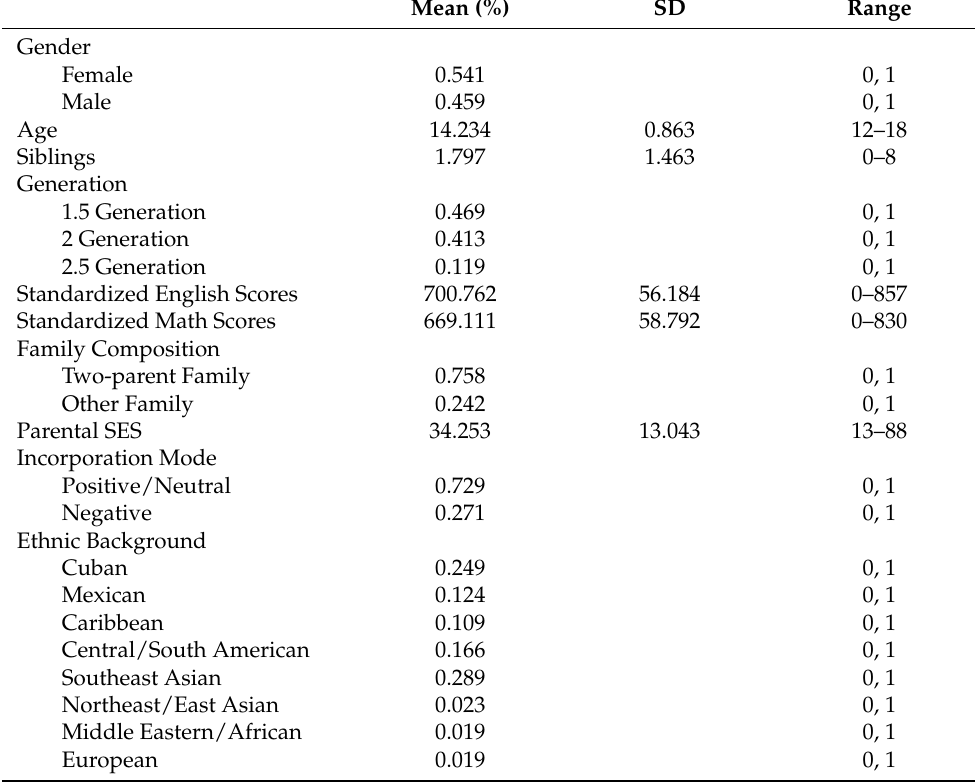
Table 1. Sociodemographic characteristic of immigrant youth participants in wave 1 of the CILS; N = 3344. Mean (%) SD